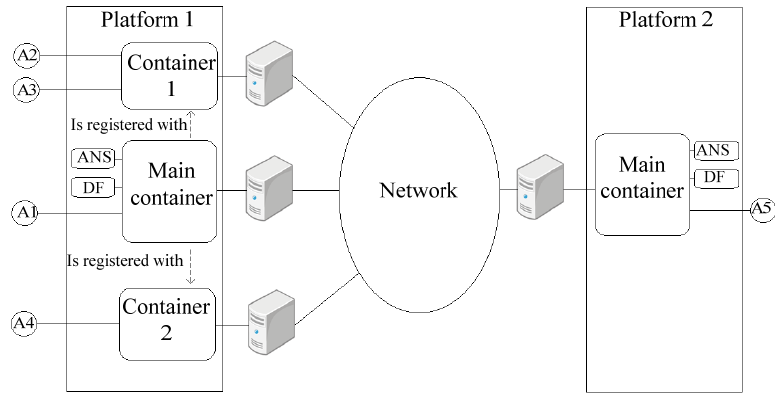
Figure 4. The connection between two different agents.